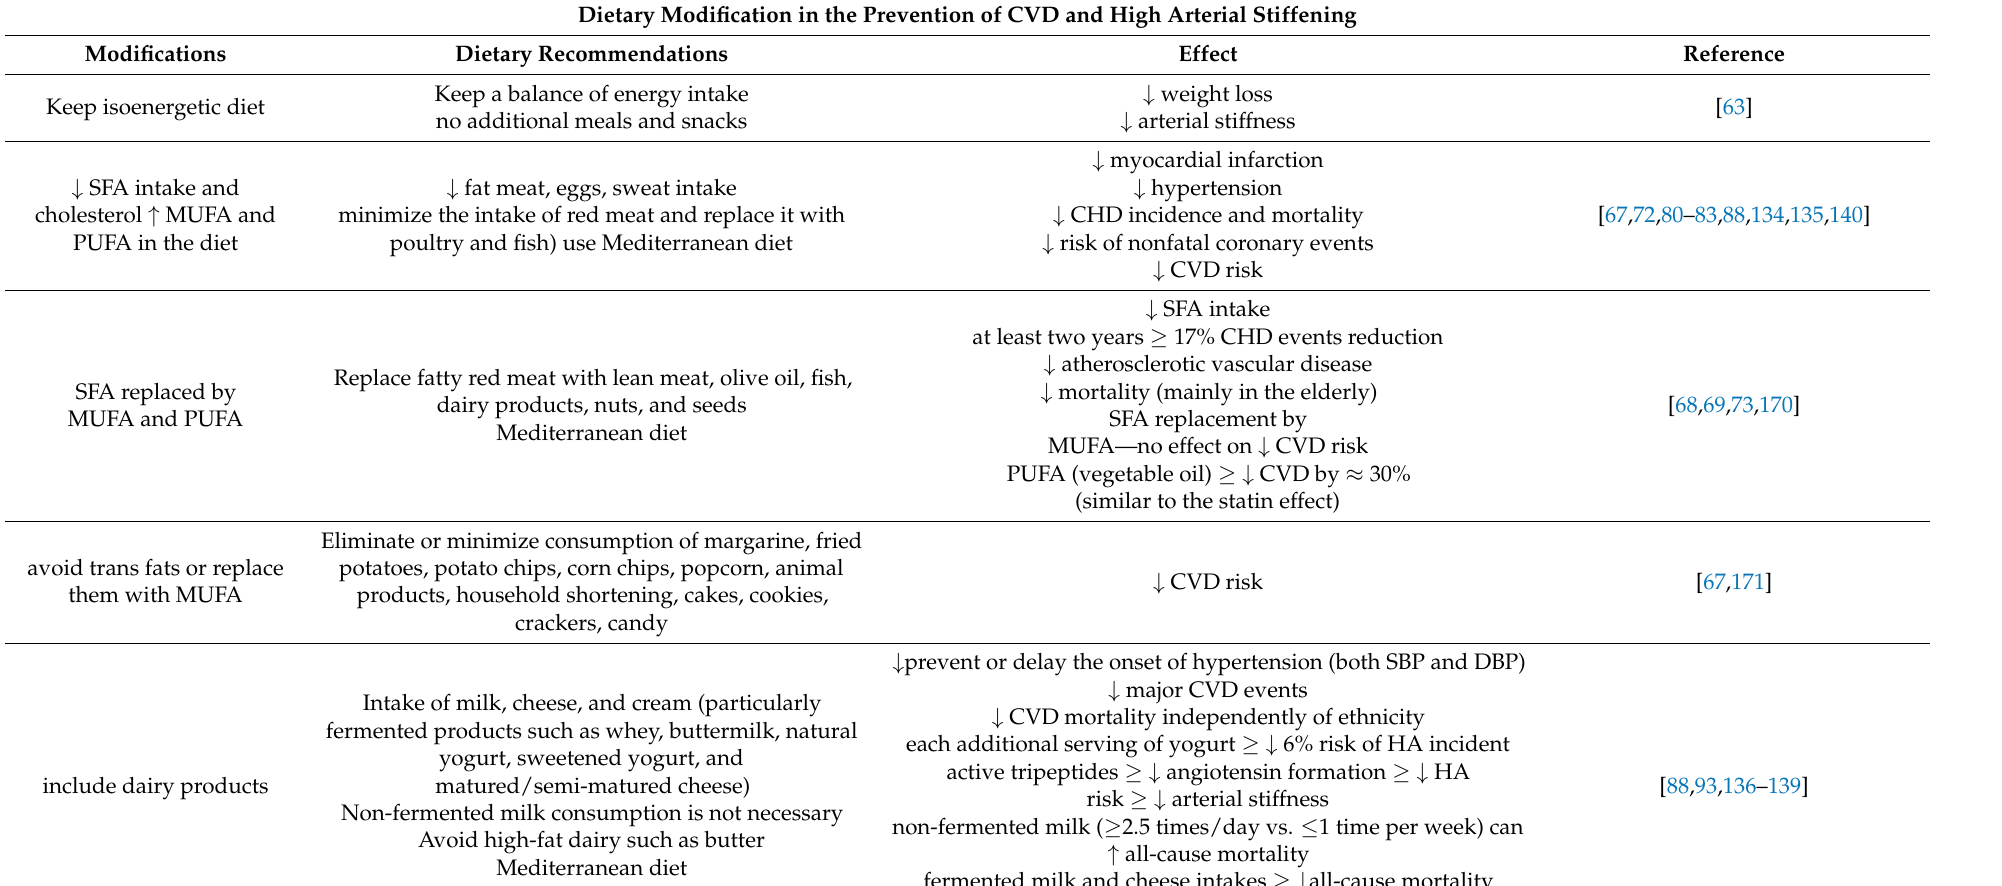
Table 2. Dietary recommendation to decrease cardiovascular risk and arterial